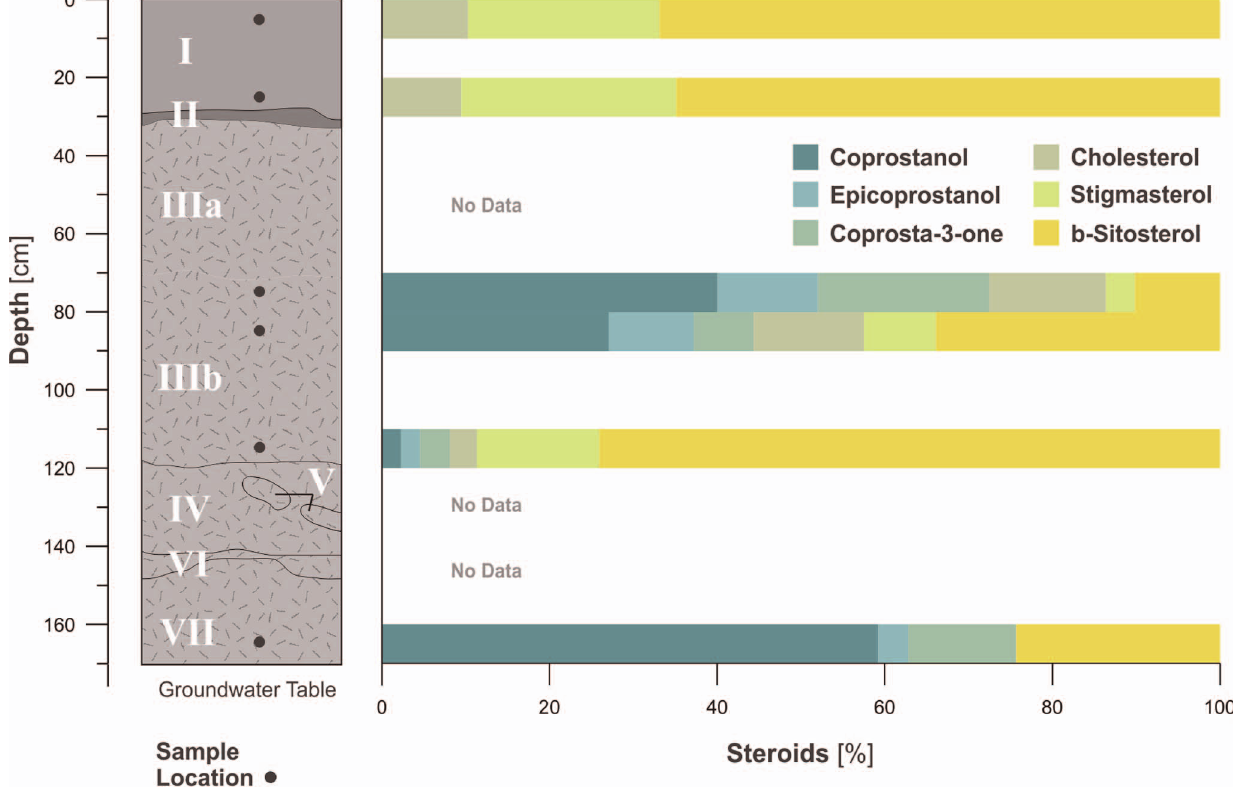
Figure 8. Steroid inventory of SM1. Single steroid abundance is expressed as percentage of total steroid amount. Cholesterol, ß-stigmasterol and b-Sitosterol occur in meat and plant tissues, while coprostanol, epicoprostanol and ß-coprostan mostly result from the digestion process of omnivores (for method details and IUPAC names see Text S1).